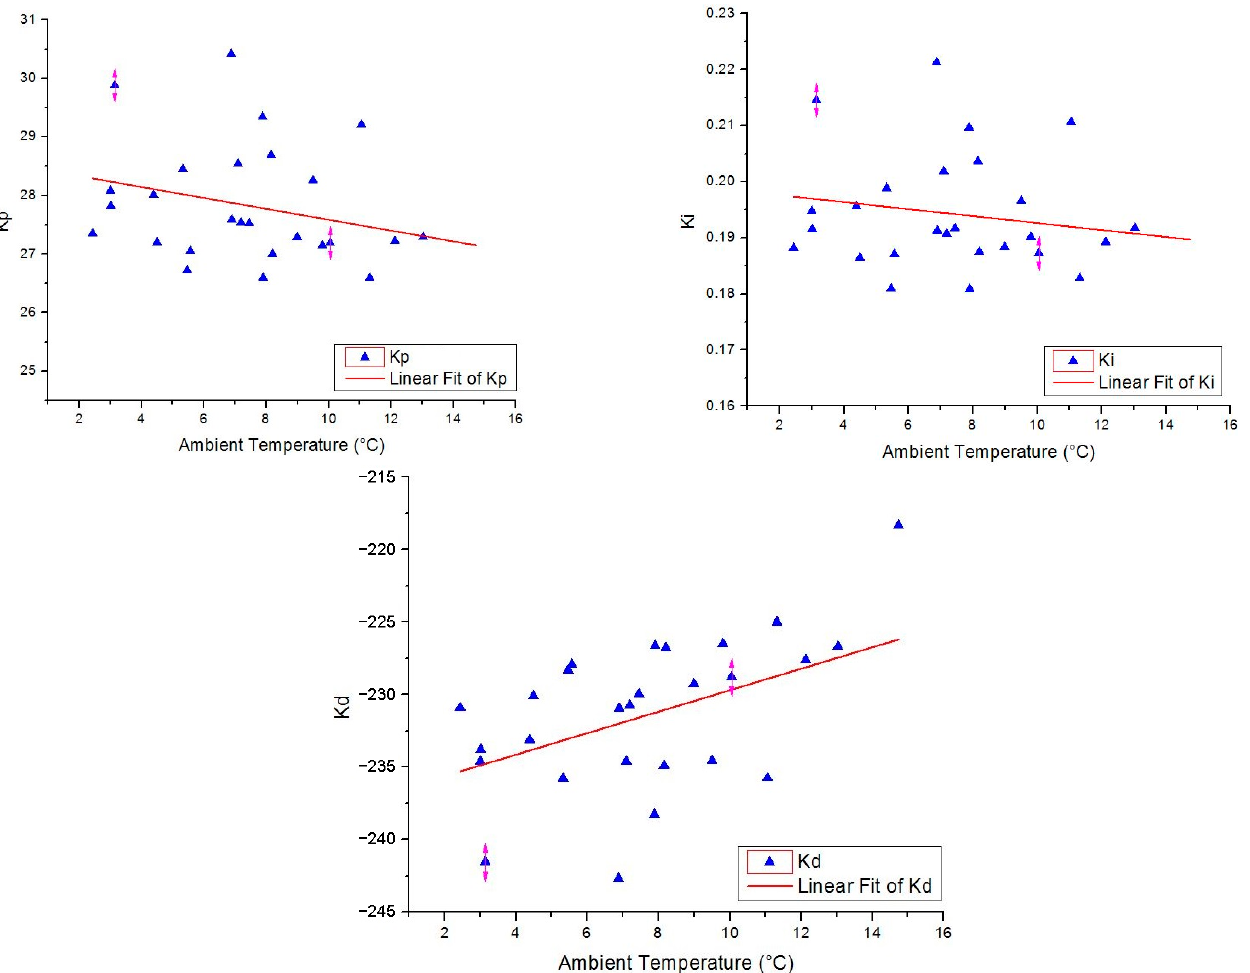
Figure 21. Linear relationship between the ambient temperature and the tuned controller gains.